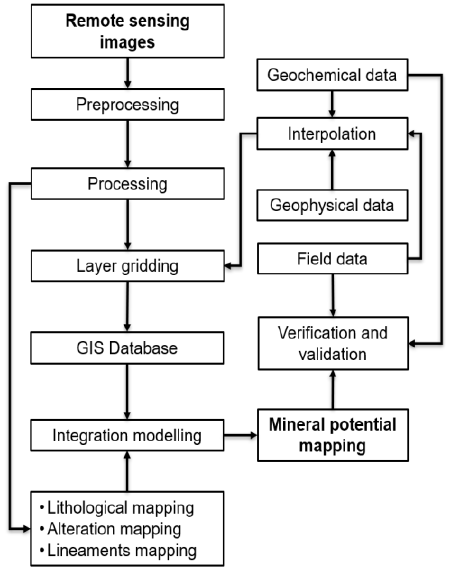
Figure 2. Flow diagram of the applied methodology.